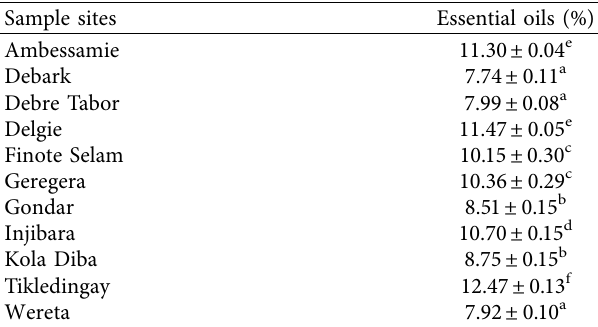
Table 2: Average concentration of essential oils of R. prinoides leaves samples collected from different sample sites.